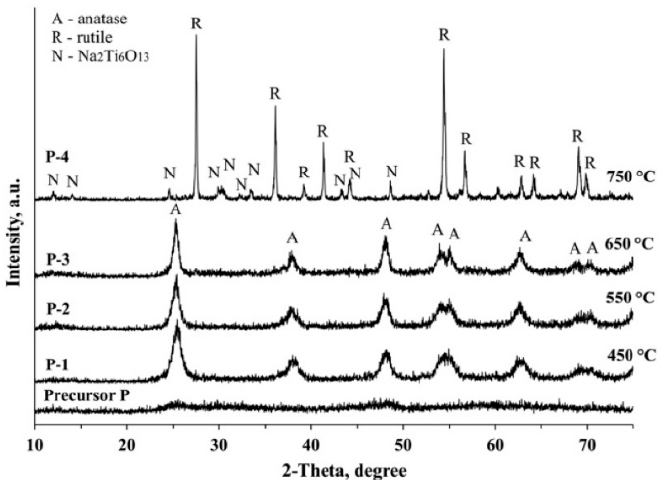
Figure 5. XRD patterns of nanocrystalline TiO 2 powders produced from the precursor P at different processing temperatures.